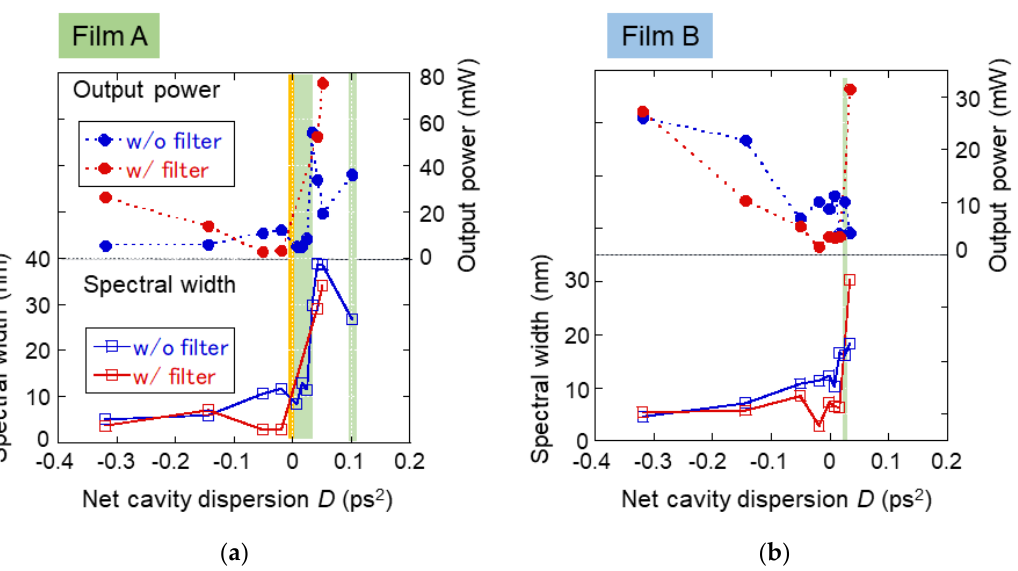
Figure 10. Variation of characteristics of output pulses as a function of net cavity dispersion when ( a ) film A and ( b ) film B were used, respectively. Green areas show the region where mode-locking was obtained only when spectral filter was not used, and orange area shows the region where mode-locking was not obtained.